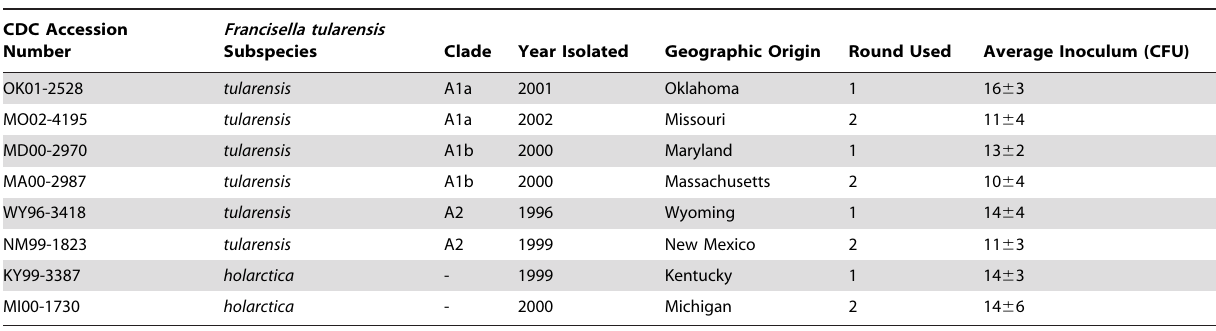
Table 1. Francisella tularensis strains used in this